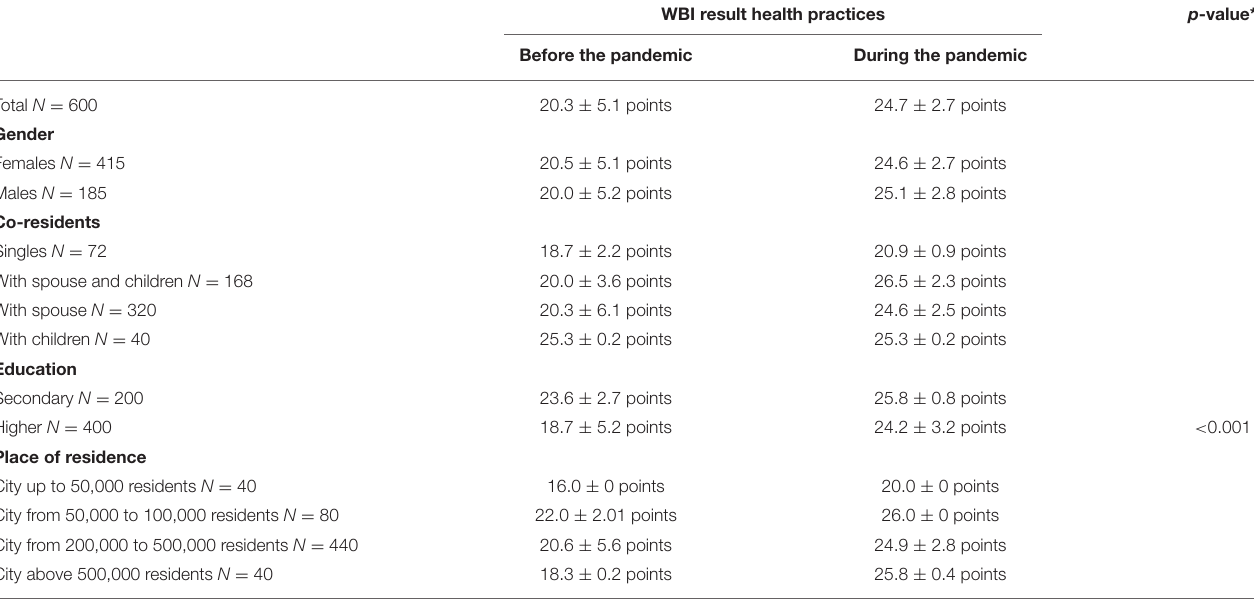
TABLE 9 | Assessment of health practices among the respondents before and during the pandemic by gender, education, co-residents, and place of